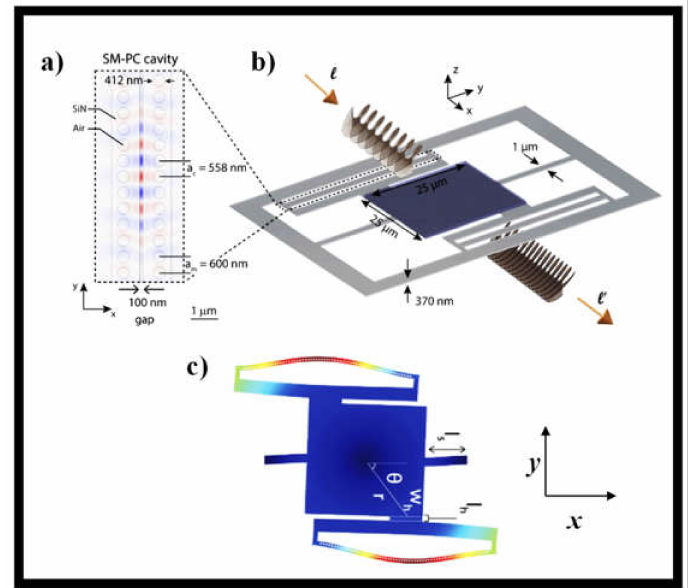
Figure 16. A diagram of the device’s geometry: ( a ) Top view of a slot-mode PhC cavity geometry and modeling of the E-field distribution of its fundamental optical mode [212]; and ( b ) The OAM detector in isometric perspective. The cavity from ( a ) is attached to the square pad by a hanger whose dimensions w h and l h are indicated in ( c ) [212]. The pad motion is moved to the nanobeam when excited by a source of torque as exhibited by the simulated displacement profile shown in ( c )